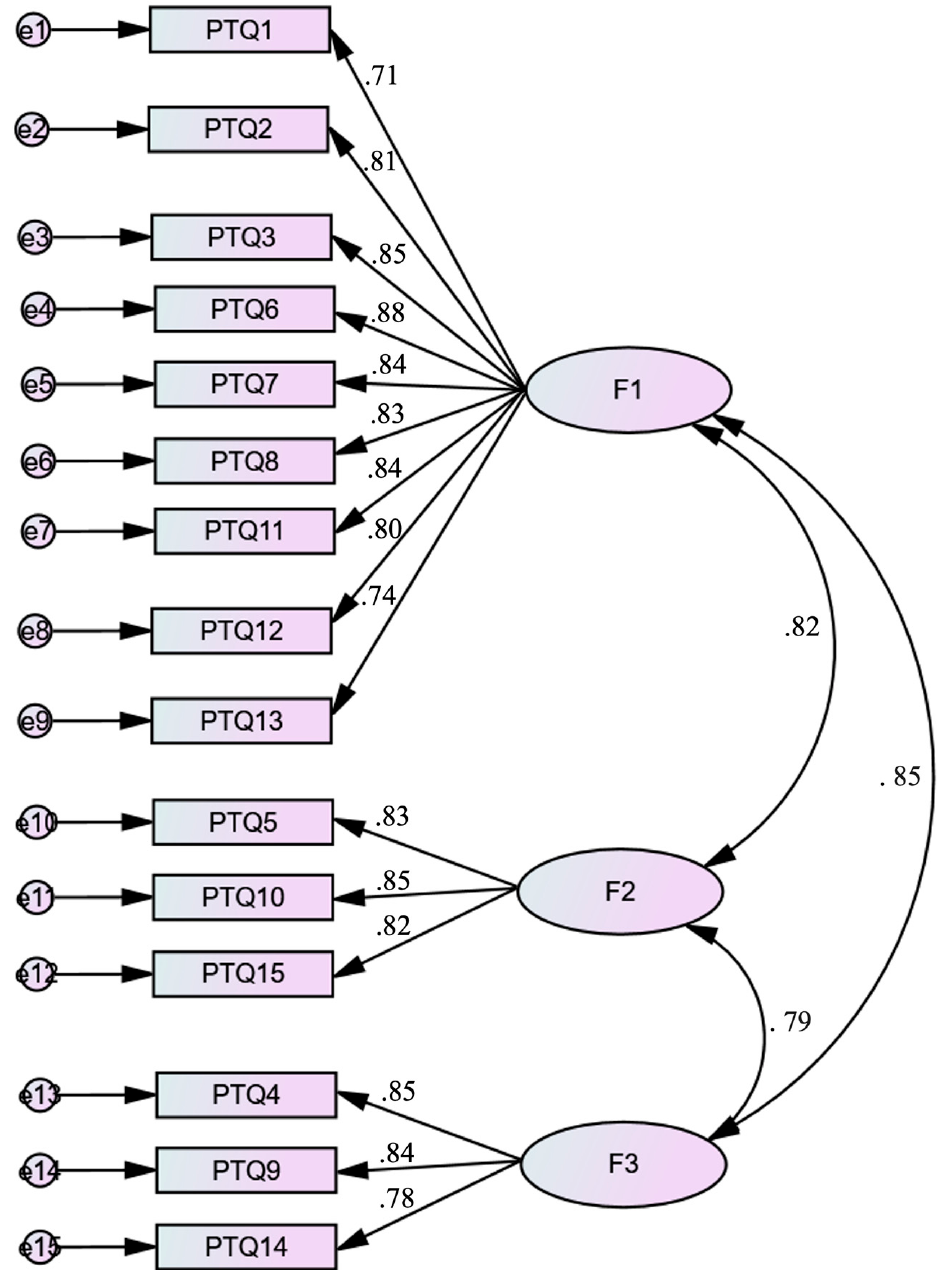
Figure 1. Standardized factor loadings of the three-factor model of the Arabic version of the Perse- verative Thinking Questionnaire (PTQ) ( p < 0.001 for all loading factors). F1 = PTQ core features, F2 = PTQ mental resources, F3 = unproductiveness.